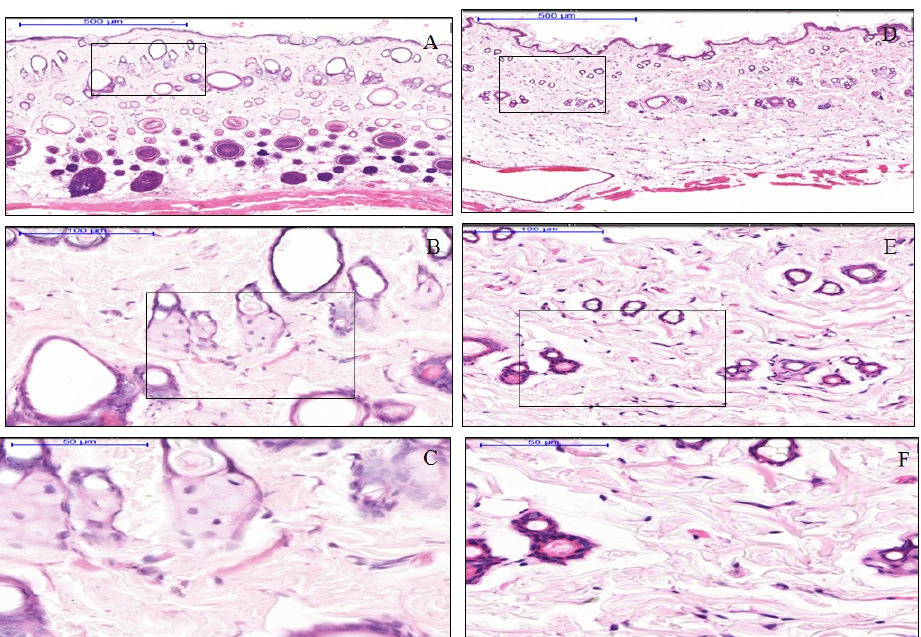
Figure 2. Scanning power view of hematoxylin and eosin (H&E) stained rat skin from the frontal regions. Infiltration of the inflammatory cells was not detected either in the control or in the expanded tissues. The dense band of typical lymphocytic infiltration in the superficial dermis was not present, similarly in the dermis, hypodermis expanded tissues samples ( A – C ), and control tissue samples ( D – F ). Expanded specimens ( A – C ) did not exhibit vascular degeneration nor prominent necrosis of individual keratinocytes.